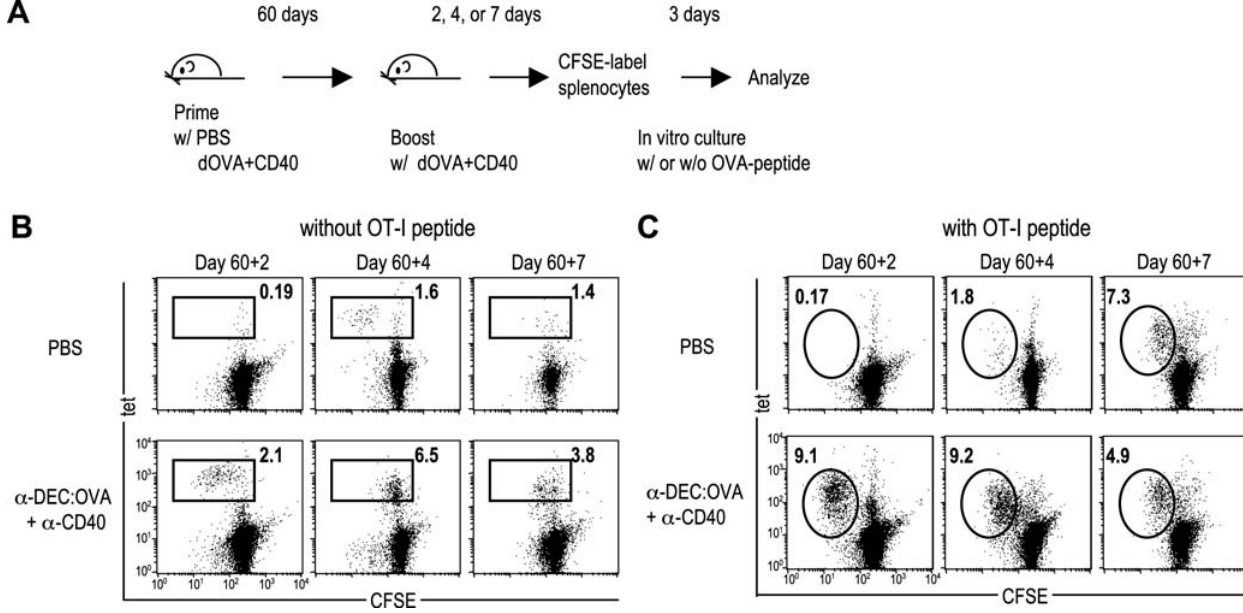
were gated on CD8 + cells. Numbers indicate the percentage of tetramer + cells in CD8 + cells. (C) Ag-driven proliferation of OVA-specific T cell in the presence of OVA-peptide. Plots were gated on CD8 + cells. Numbers indicate the percentage of CFSE low tetramer + cells in CD8 + cells.